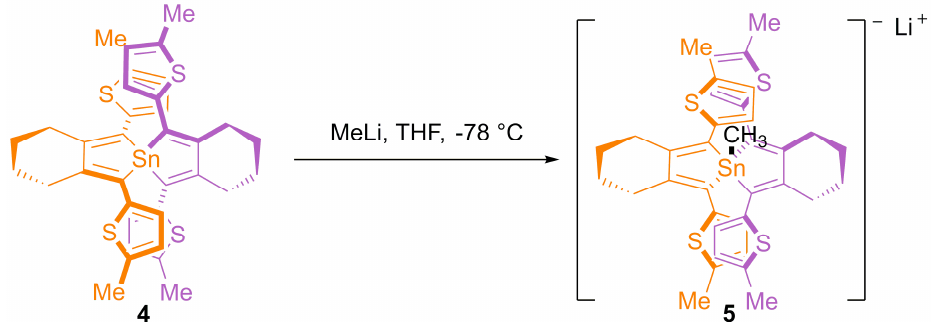
Figure 4. ( a ) Experimental absorption/emission spectra in chloroform and the calculated absorption spectrum. ( b ) Emission spectra at different temperatures in 2-methyl-tetrahydrofuran and a picture of the irradiated solution of spirostannole 4 (green luminescence) in 2-methyltetrahydrofuran at 80 K. In addition, we studied the reaction of spirostannole 4 with methyllithium [27,28]. Under inert conditions, a solution of methyllithium was added to a solution of spirostannole 4 in tetrahydrofuran (THF) at 195.15 K in an inert NMR tube (Scheme 2). The colour changed immediately from orange- yellow to red.